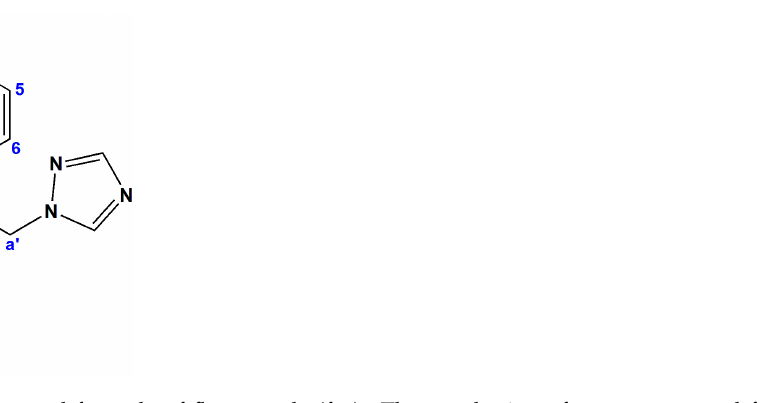
Figure 1. Structural formula of fluconazole (fcz). The numbering of atoms was used for NMR assignation and does not match the one applied in the X-ray study of the complexes 1 and 2 .